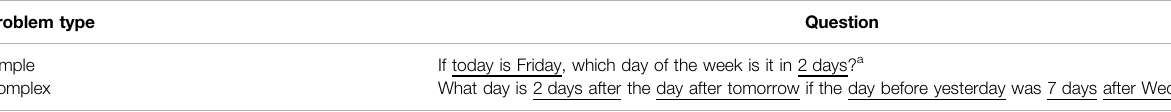
TABLE 1 | Example of a simple and complex problem used in the problem-solving task.